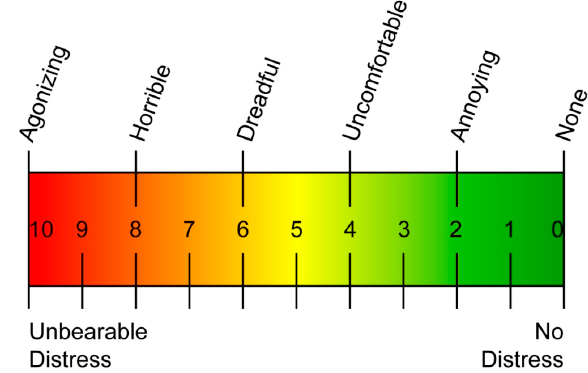
Figure 2. Visual analogue scale (VAS).